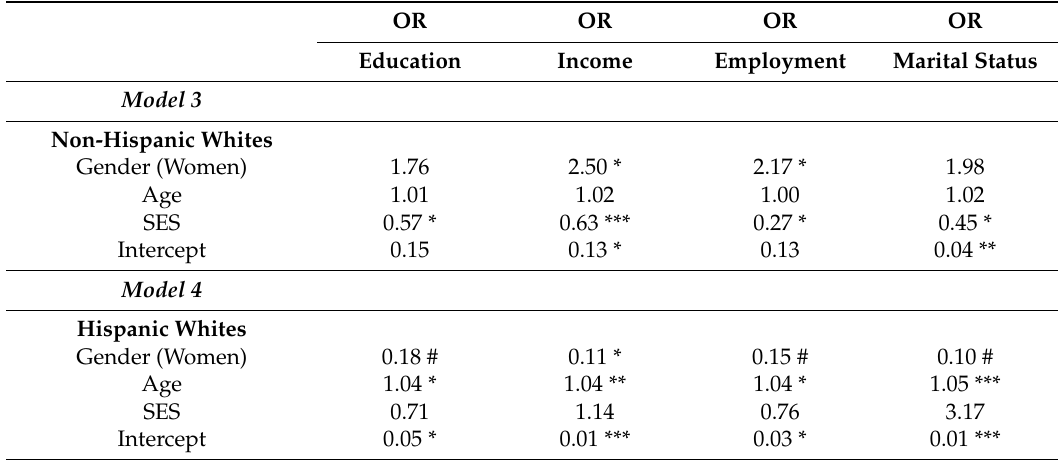
Table 4. Summary of logistic regressions between SES (education, income, employment, and marital status) and poor oral self-rated health (SRH) in non-Hispanic and Hispanic Whites. OR OR OR OR Education Income Employment Marital Status Model